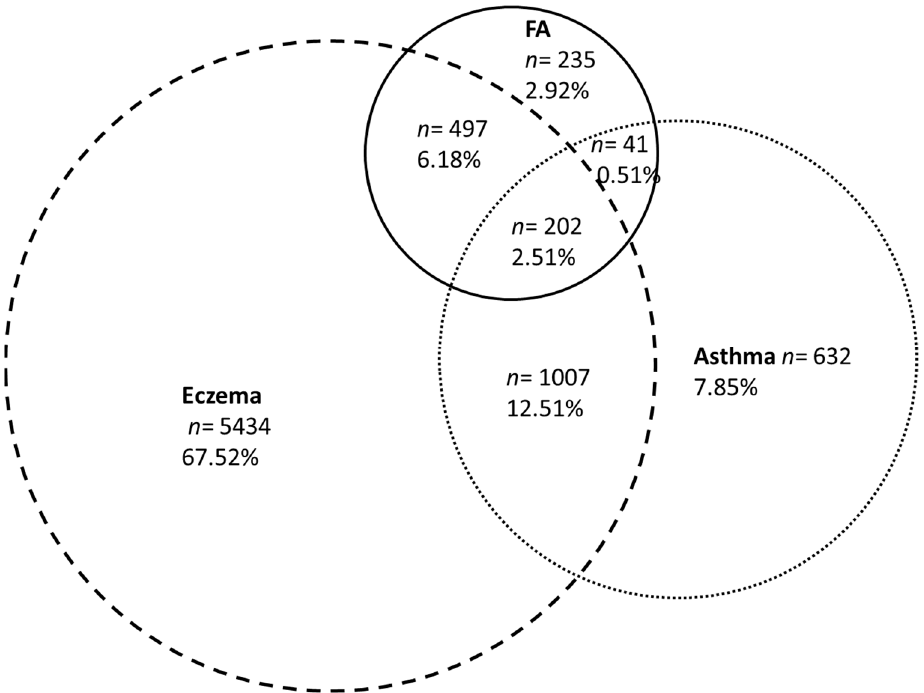
Figure 3. Venn diagram depicting the overlap of food allergies (FA), eczema and asthma in children with at least one allergic disease up to 5.5 years of age.